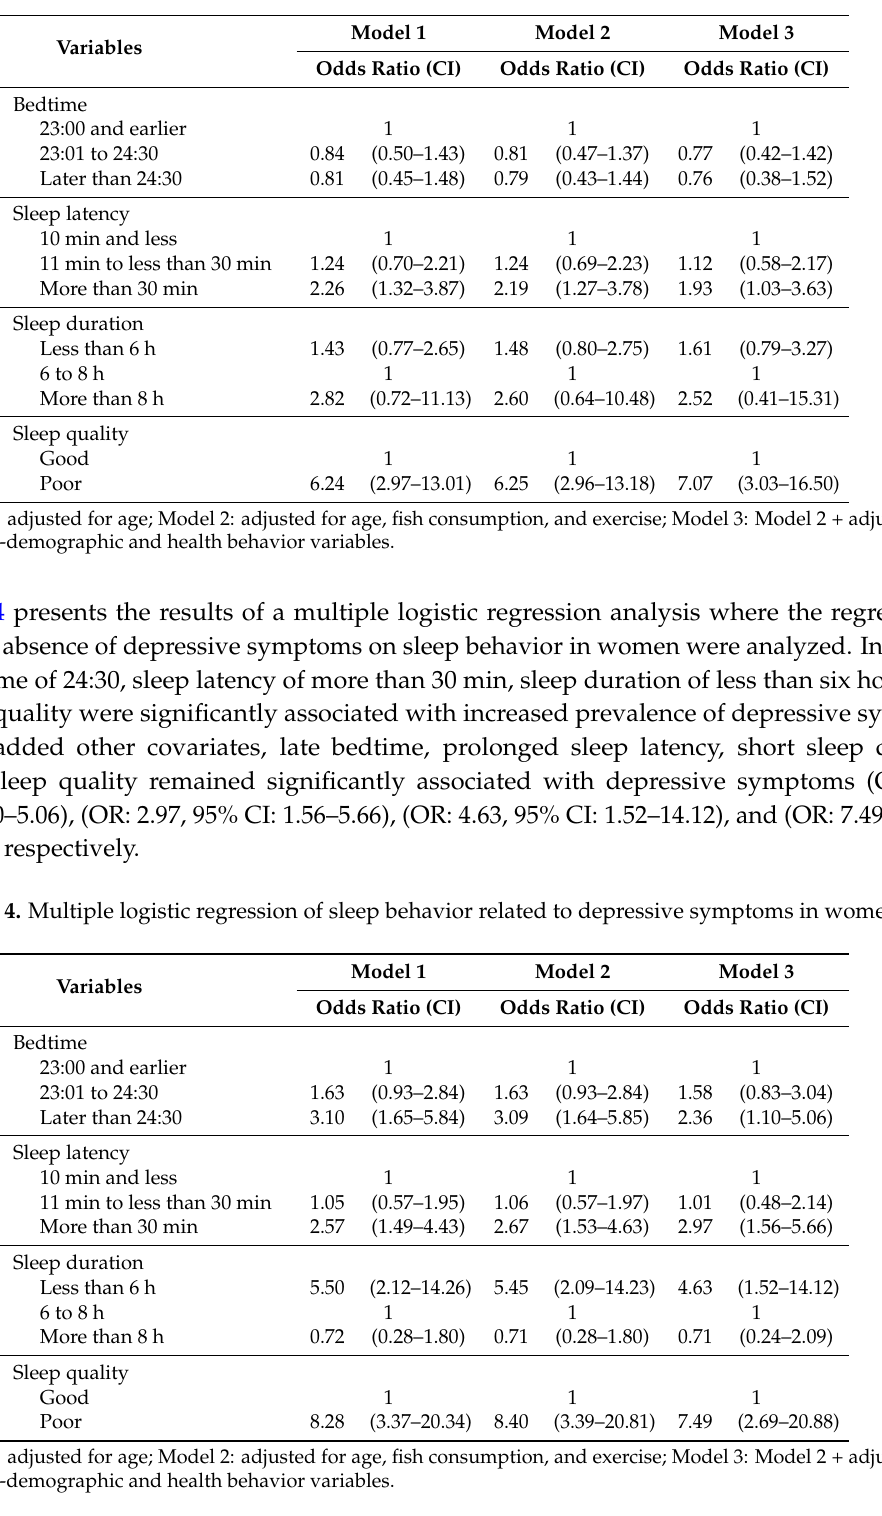
Table 3. Multiple logistic regression of sleep behavior related to depressive symptoms in men.